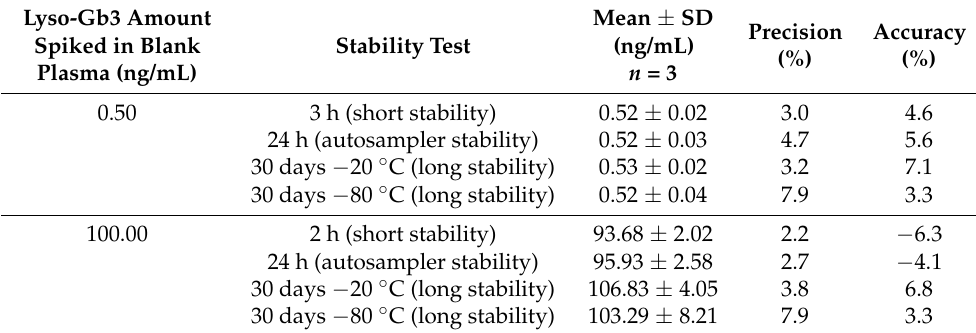
Table 2. Stability data of lyso-Gb3 assay.